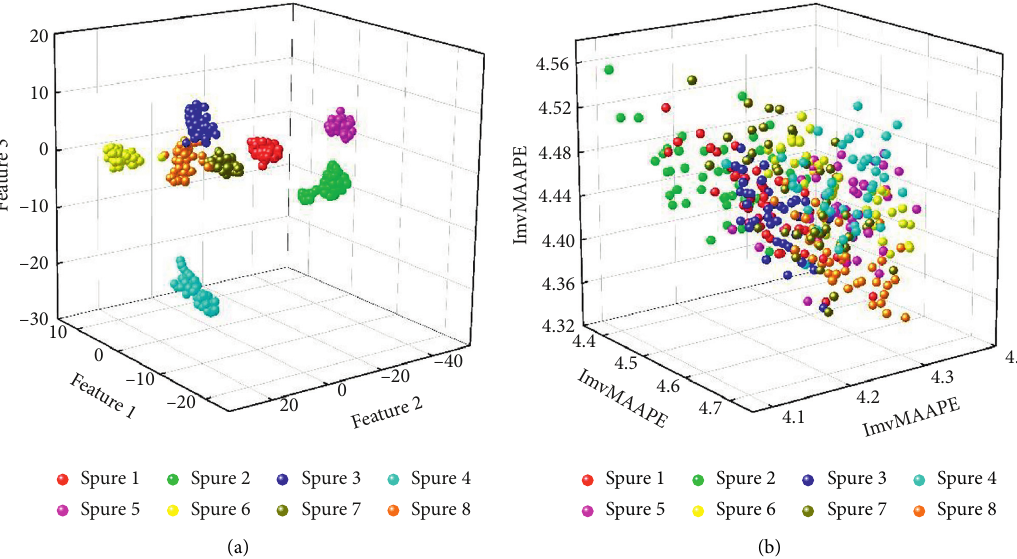
Figure 8: (a) The distinguishing effect of characteristic vectors (3 dimensional) in each working condition after dimensionality reduction by the t-SNE method; (b) The distinguishing effect of feature vectors (3 dimensional) in each working condition without using the t-SNE method.